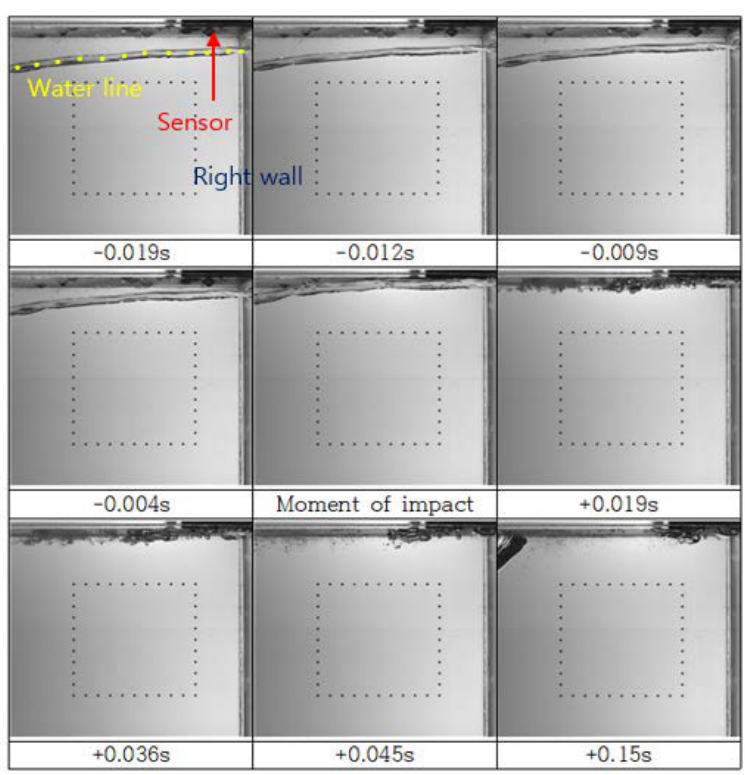
Figure 9. Snapshots of Flow: SWAY (Wet).